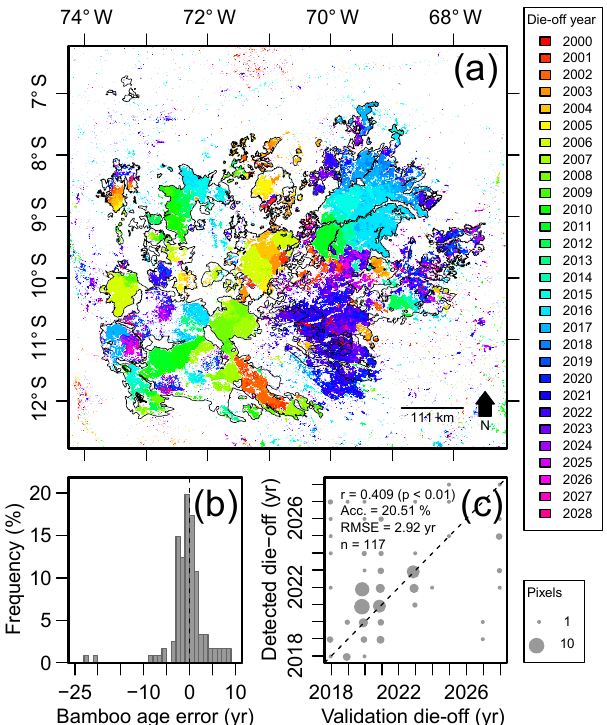
Figure 9. MODIS bamboo die-off prediction map from 2000 to 2028 using the empirical curves of the near-infrared 1 (NIR-1) re- flectance as a function of bamboo cohort age (a) . Validation be- tween predicted die-off (2017–2028) and visual interpreted die- off from the previous life cycle in Landsat false-color composites (1985–2000) (c) and residuals distribution (a) . The dashed line rep- resents the 1 : 1 line in (c) and an age residual of 0 in (b) . The size of circles is related to the number of pixels that hit the same ob- served/estimate die-off year.